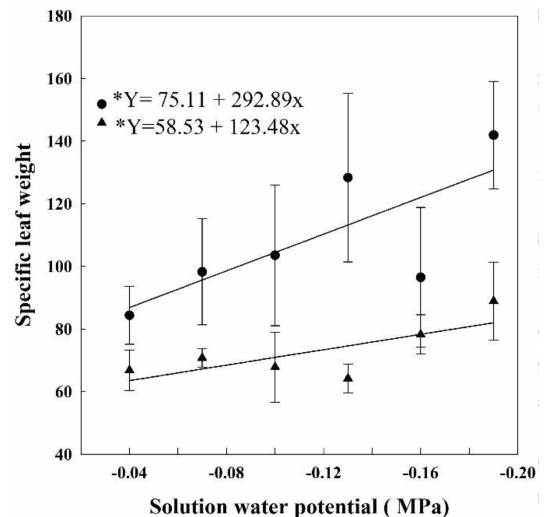
Figure 4. Specific leaf weight in rice plants grown at different solutions with different water potentials. The error bars represent the standard error. * p -value < 0.01; • = HET; (cid:78) =